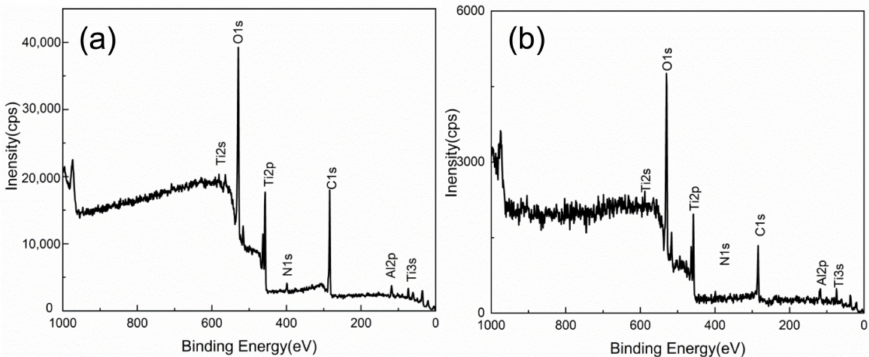
Figure 7. XPS survey spectrum of high-temperature oxide films at 800 ◦ C for 0.5 h: ( a ) Mechanical grinding, ( b ) Laser cleaning.